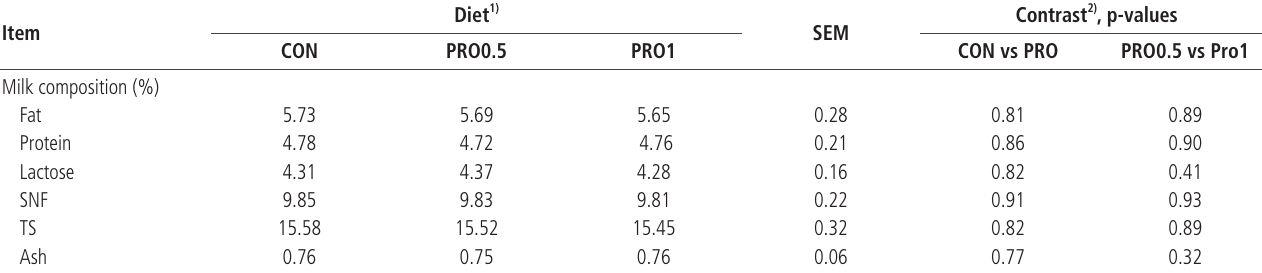
Table 2. Milk composition on different observation days during pre-weaning period